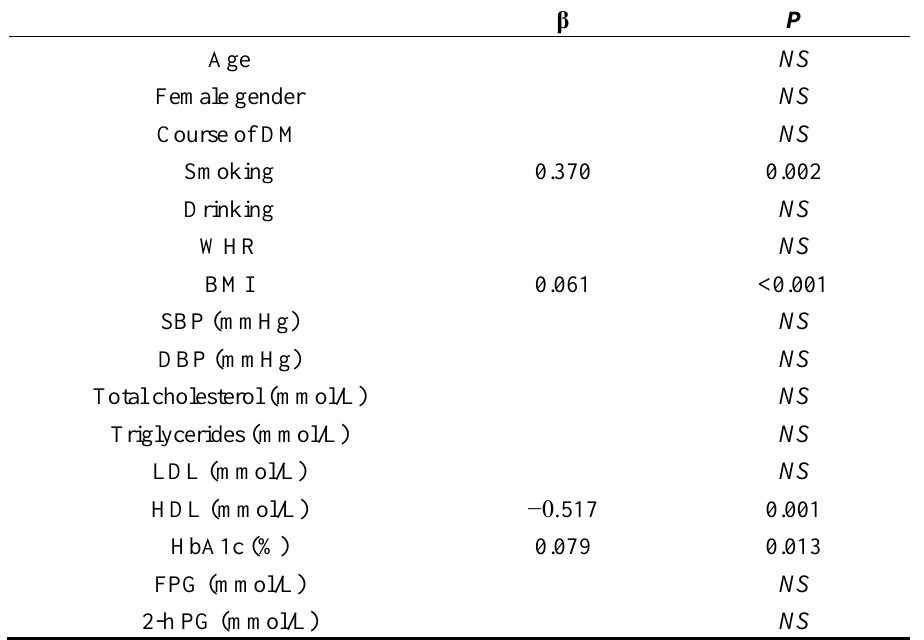
Table 4. Relevant Variables associated with WBC Count in previously diagnosed DM.